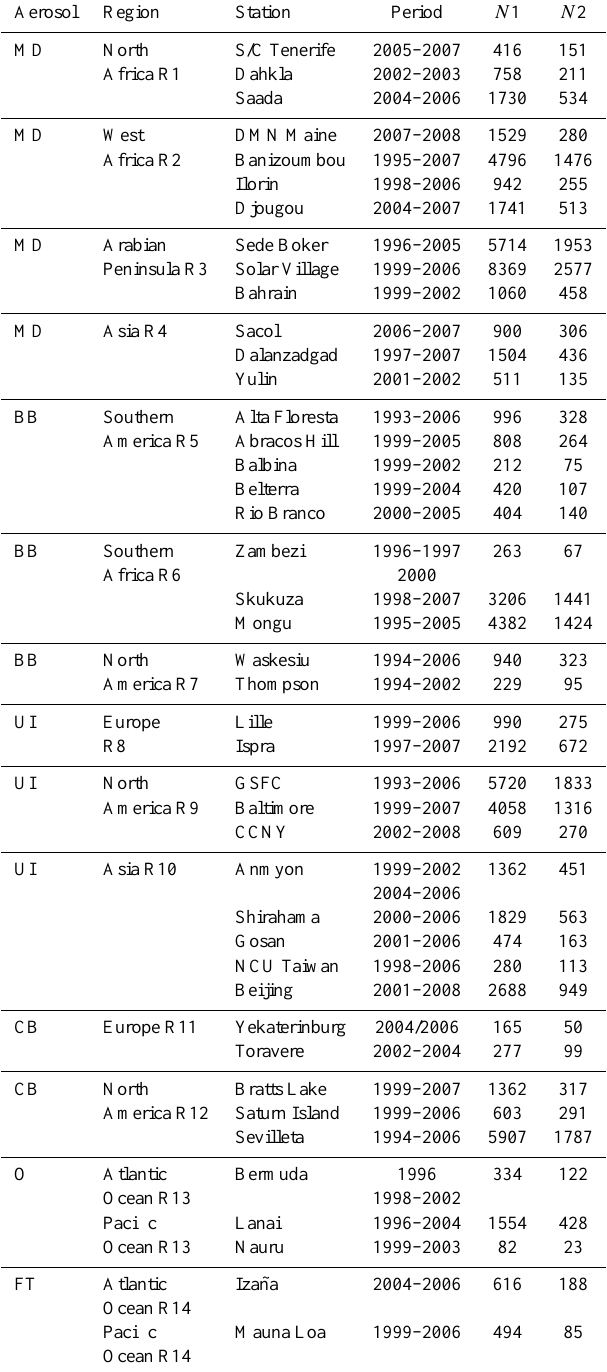
Table 1. AERONET stations grouped into aerosol type and region ( N 1 is the number of almucantar retrievals at the sza range 50 ◦ – 80 ◦ and N 2 is the number of almucantar retrievals at the sza range 55 ◦ –65 ◦ for each